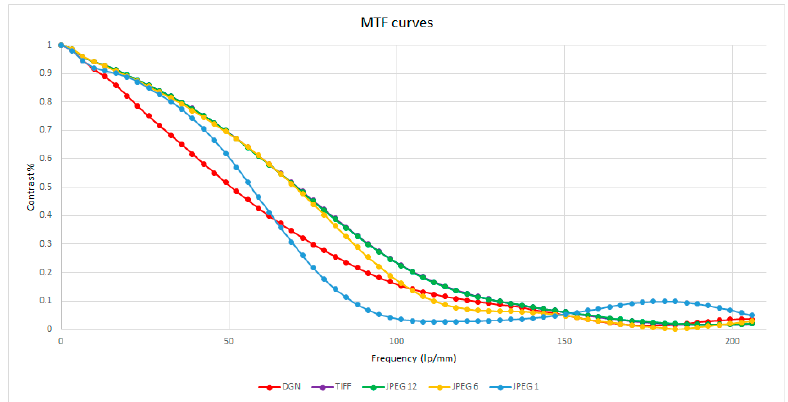
Figure 8. Modulation transfer function (MTF) curves.